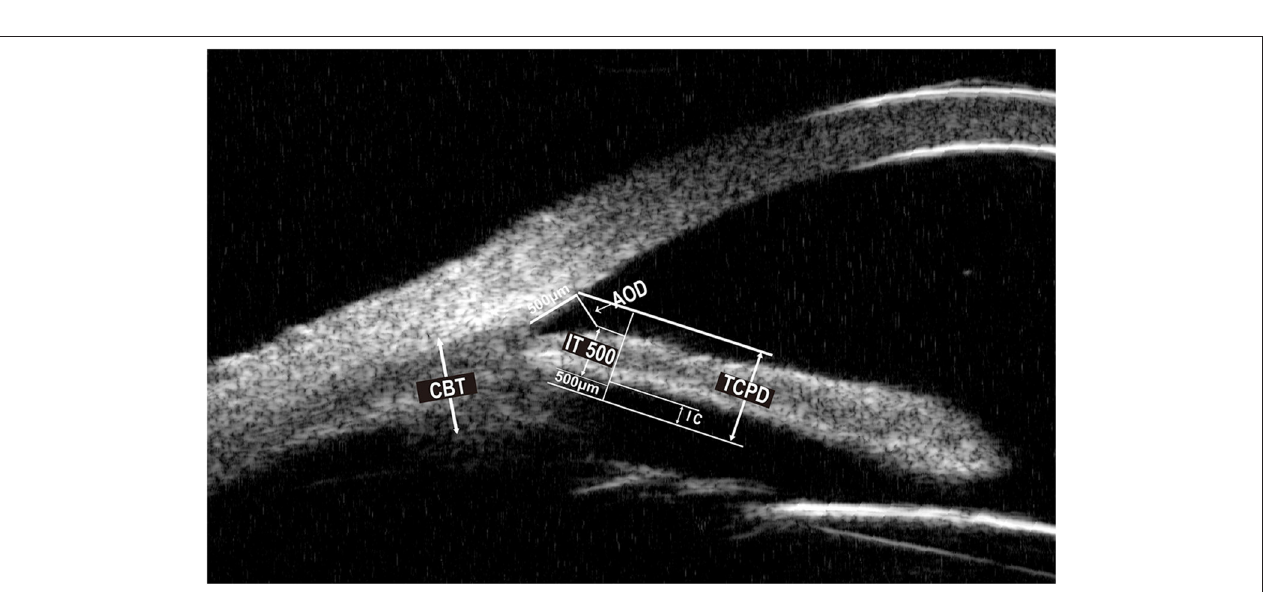
FIGURE 2 | Ultrasound biomicroscopic (UBM) image of AOD500, TCPD, IT500, CBT, IC. AOD500, angle opening distance 500. TCPD, trabecular ciliary process distance. IT500, peripheral iris thickness 500. CBT, ciliary body thickness. IC, iris convex.